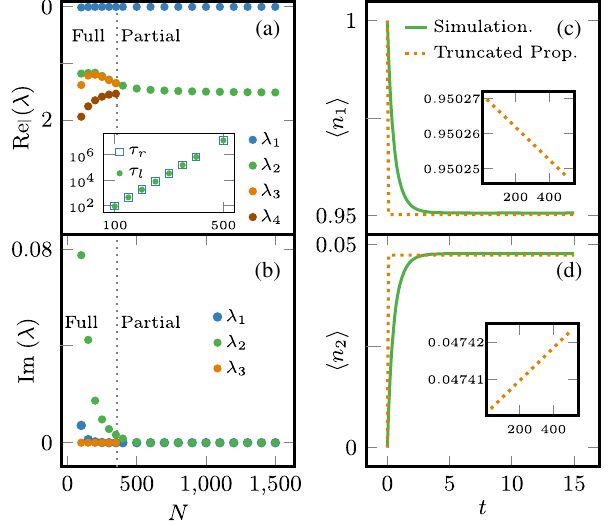
FIG. 7. Real (a) and corresponding imaginary (b) parts of the four most dominant eigenvalues with a distinct and finite real part for different N and for β ¼ 7 as a representative of the AM phase. The inset in (a) depicts the relaxation timescale τ and the lifetime r of the metastable state τ as a function of N . Furthermore, the l mean occupation density h n as a function of time for both the i i full [Eq. (25b)] and truncated [Eq. (28)] propagation [ i ¼ 1 in (c) and i ¼ 2 in (d)] for N ¼ 10 2 is